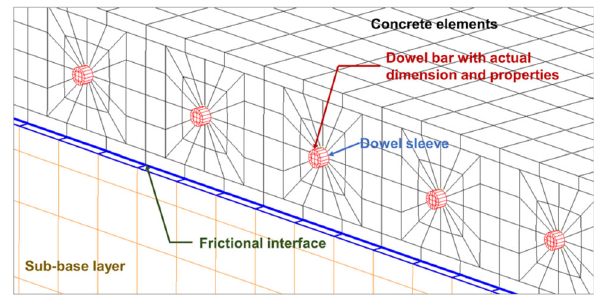
Fig. 9 Modeling of the interface